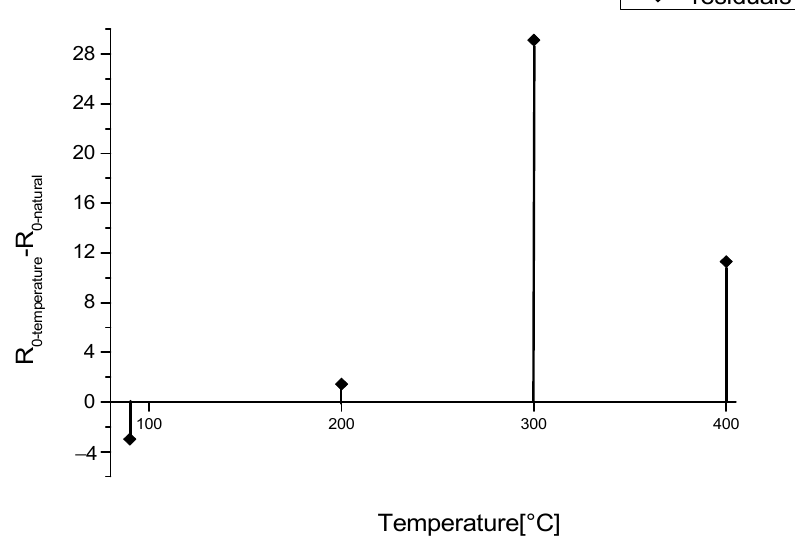
Figure 4. Difference between R 0 -values obtained from artificial aged models heated at different temperatures ( R 0 -temperature) and the R 0 -value of natural aged model ( R 0 -natural).